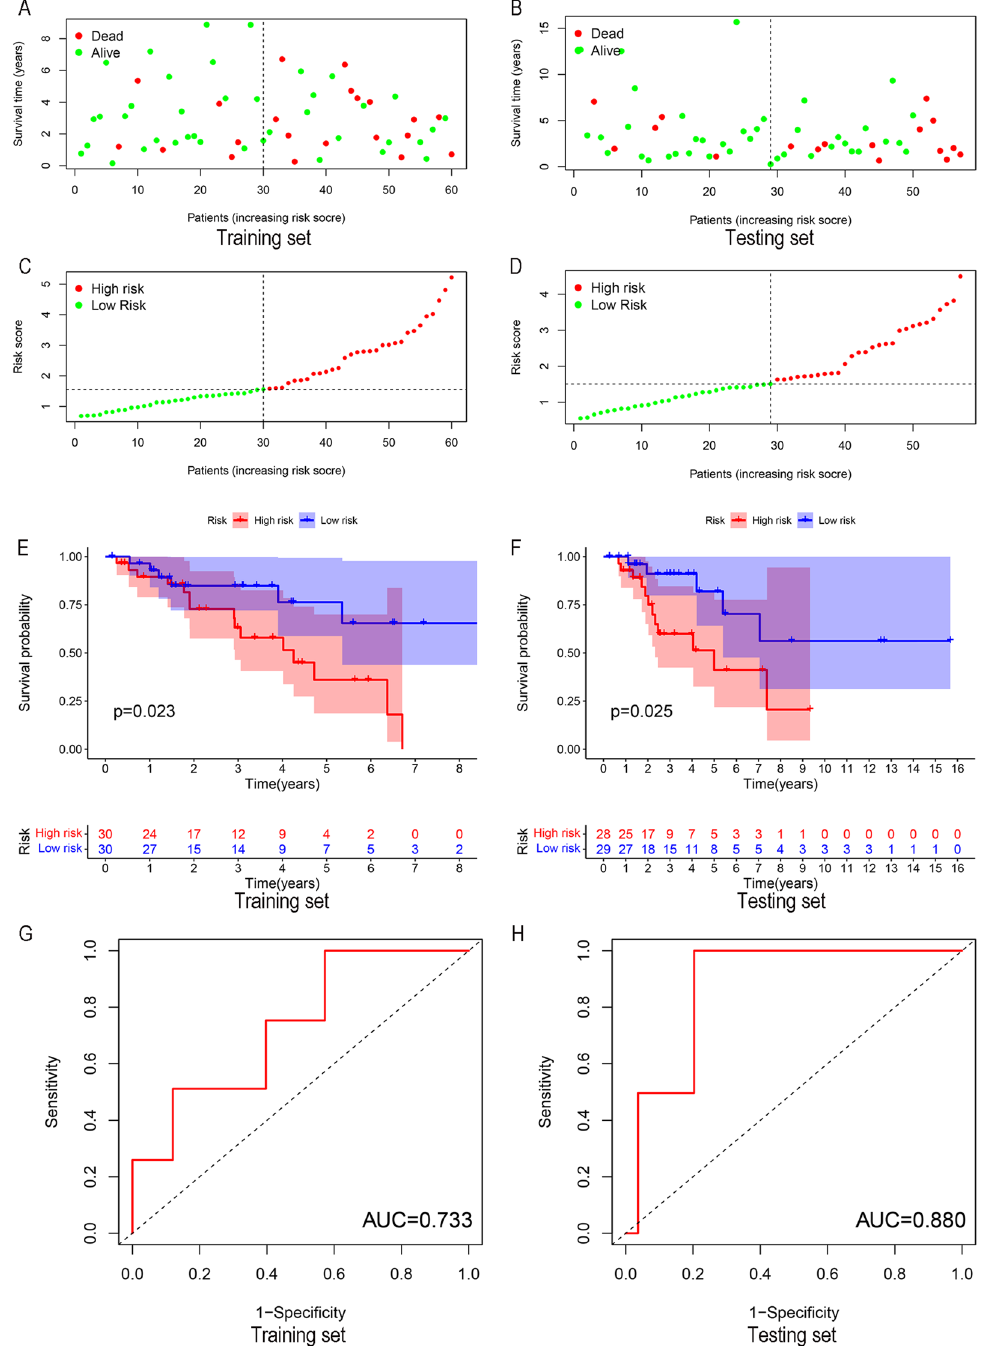
Figure 3. Constructing a prognostic model. ( A-D ) According to different risk values, patients with osteosarcoma are divided into high-risk groups and low-risk groups. ( E-F ) Construct a prognostic model between patients in the high-risk group and the low-risk group. The results show that patients in the low-risk group have a better prognosis. ( G-H ) Draw ROC curve to evaluate the accuracy of the prognostic